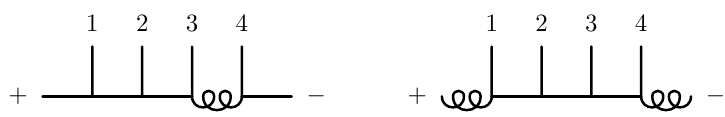
Figure 4 . The half integrand in (4.3) receives contributions from forward limits in both scalars (drawn in the left panel) and gluons (drawn in the right